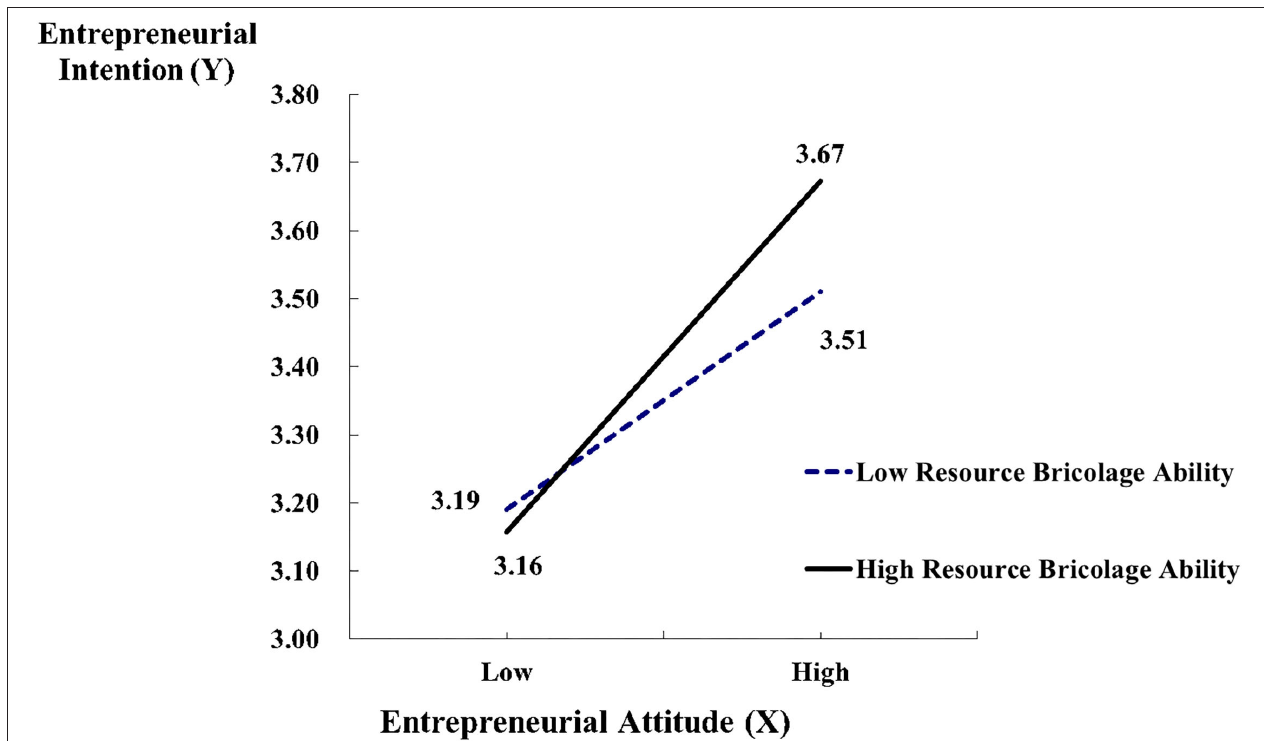
FIGURE 5 | The moderating effect interaction